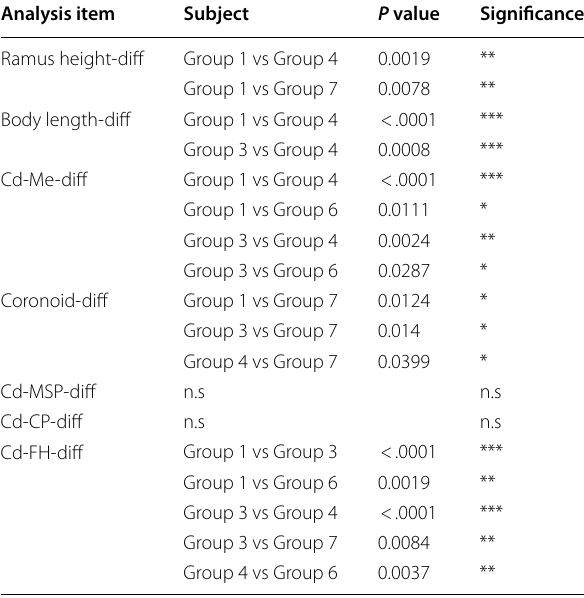
Table 5 Comparison of analysis items among groups